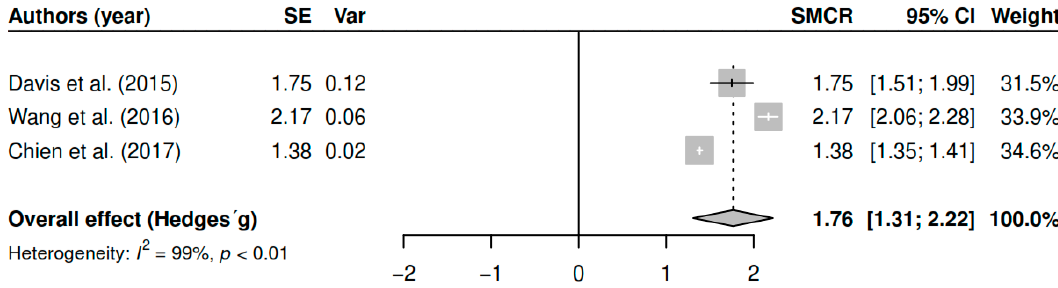
Figure 3. Forest plot for the model of random-effects and the values of Hedges’ g statistics in the overall symptomatology variable (follow-up).